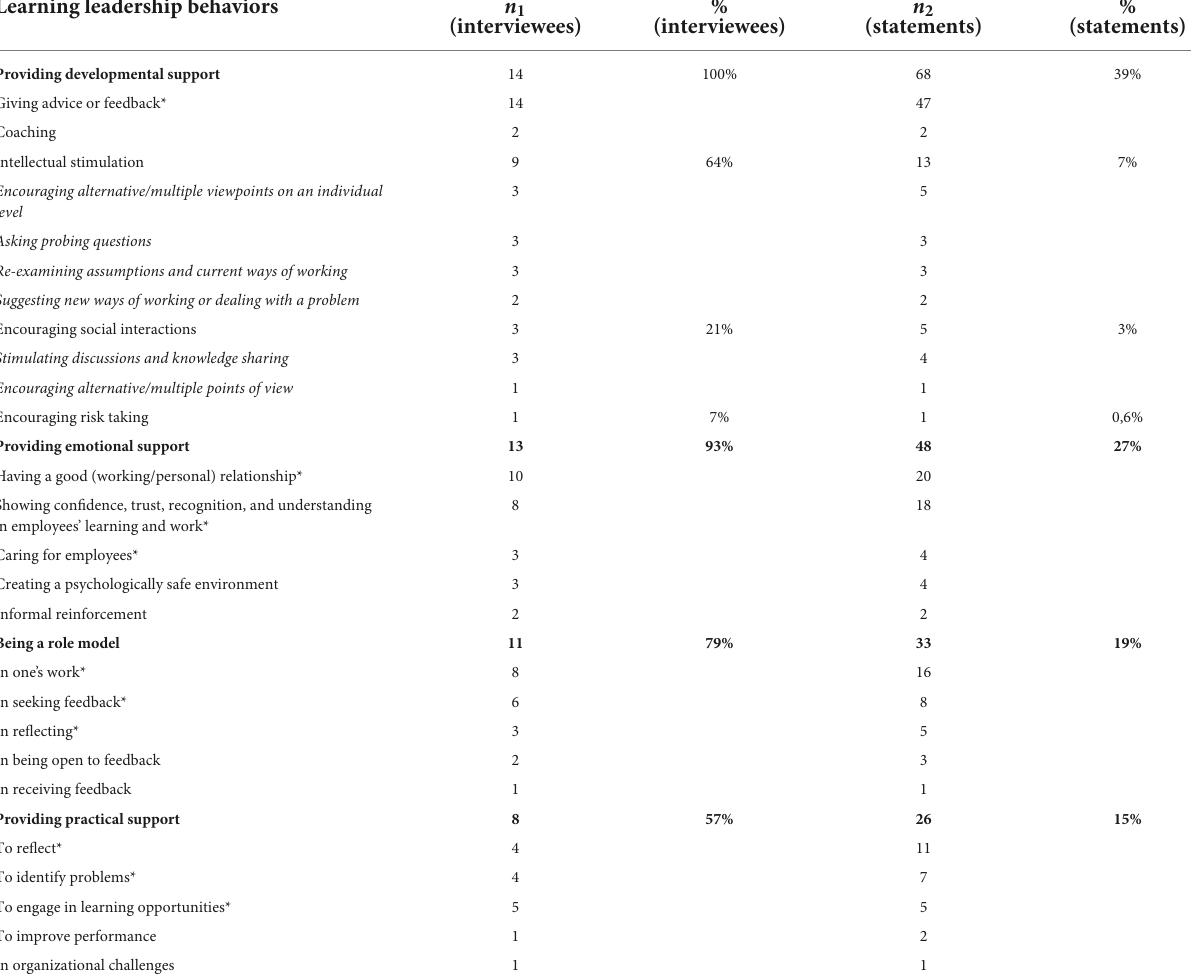
TABLE 7 Frequencies and percentages of learning leadership behaviors ( n 1 = 14 interviewees, n 2 = 175 statements). Learning leadership behaviors n 1